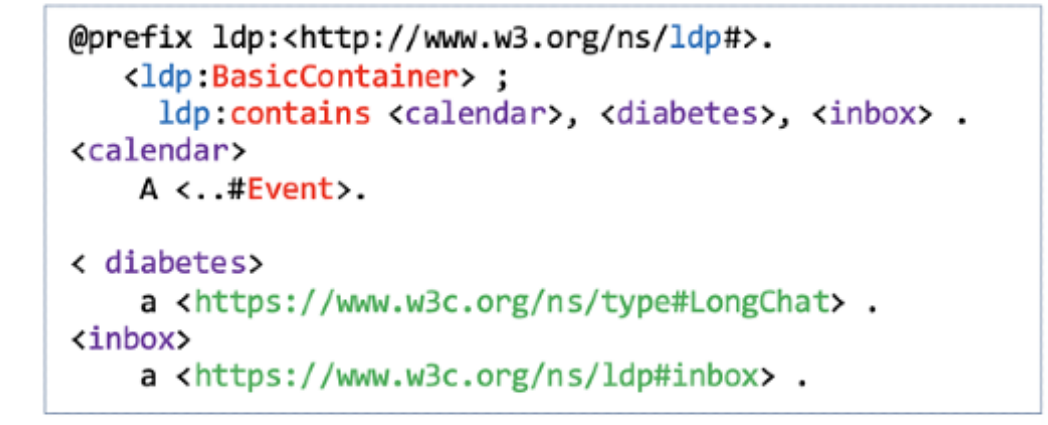
Figure 5. Hierarchy of containers under Bob’s